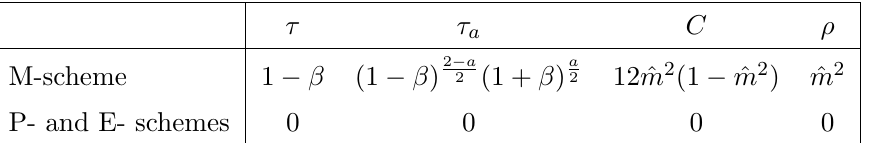
p 1 (cid:0) 4 ^ m 2 , the velocity of the quarks